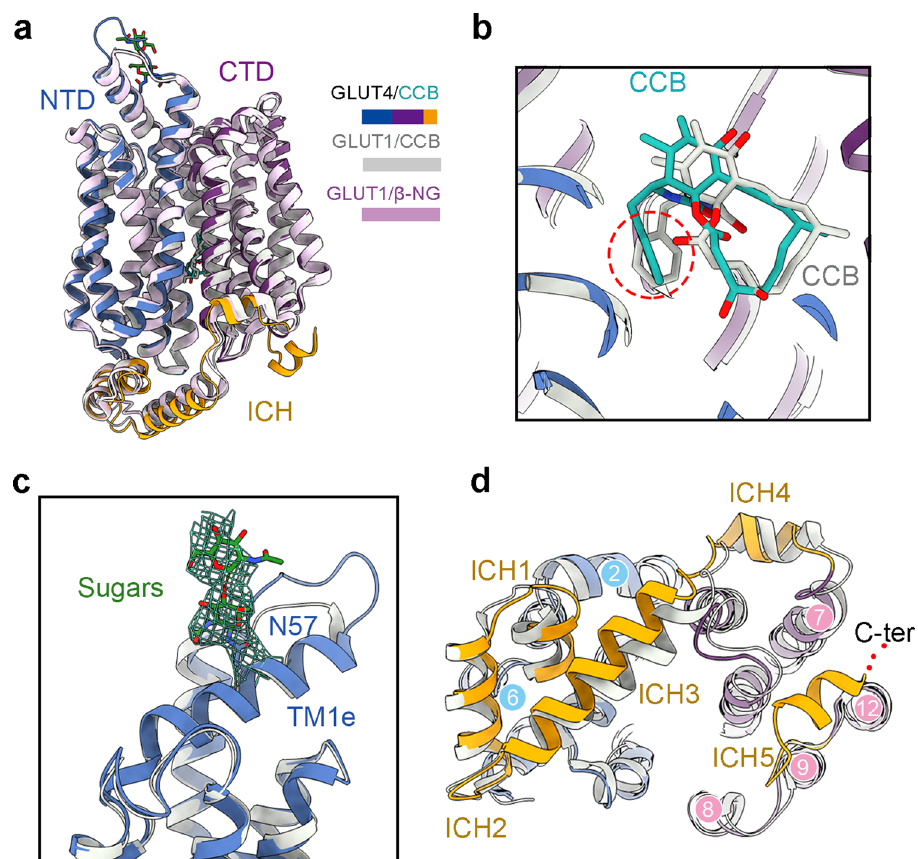
Fig. 3 Structural comparison of inward-open GLUT4 and GLUT1. a Structural comparison of GLUT4 and GLUT1. Shown here are superimposed structures of GLUT4 (domain colored) with GLUT1 bound to CCB (silver, PDB code: 5EQI) or in the presence of β -NG (pink, PDB code: 4PYP). The TM region remains nearly identical. b Similar coordination of CCB by GLUT4 and GLUT1. Among all the CCB-coordinating residues, there are only two varied residues, Ile42 and Asn176 in GLUT4 are respectively substituted with Thr30 and His160 in GLUT1. c Cryo-EM analysis reveals the glycosylation site on GLUT4. The density for two sugar moieties (green) attach to Asn57 on the extracellular helix TM1e of GLUT4 is contoured at 4 σ . d Deviations of the ICH domain between GLUT4 and GLUT1. In contrast to the nearly identical structures of the TM region, there are deviations of ICH3 and ICH4 between GLUT4 and GLUT1. More importantly, the C-terminal ICH5 is resolved in GLUT4